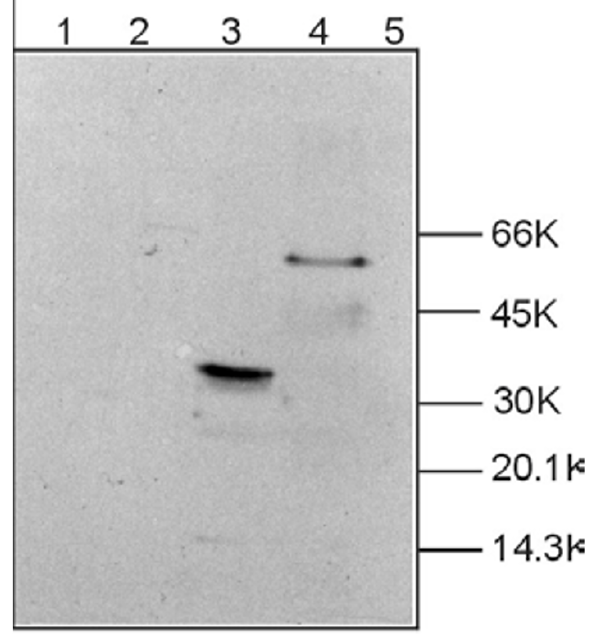
Figure 7 Western blot analysis of P0 protein levels with anti- bodies directed against the V5-epitope. The V5 epitope fused in-frame with P0 reveals expected molecular weights for GFP and GFP fused with P0 proteins. Lane 1: purified recombinant GFP. Lane 2: crude protein extract of sciatic nerve. Lane 3: protein extract of GFP-V5 transfected insect cells. Lane 4: protein extract of wild type P0-GFP-V5 trans- fected cells. Lane 5: moelcular weight